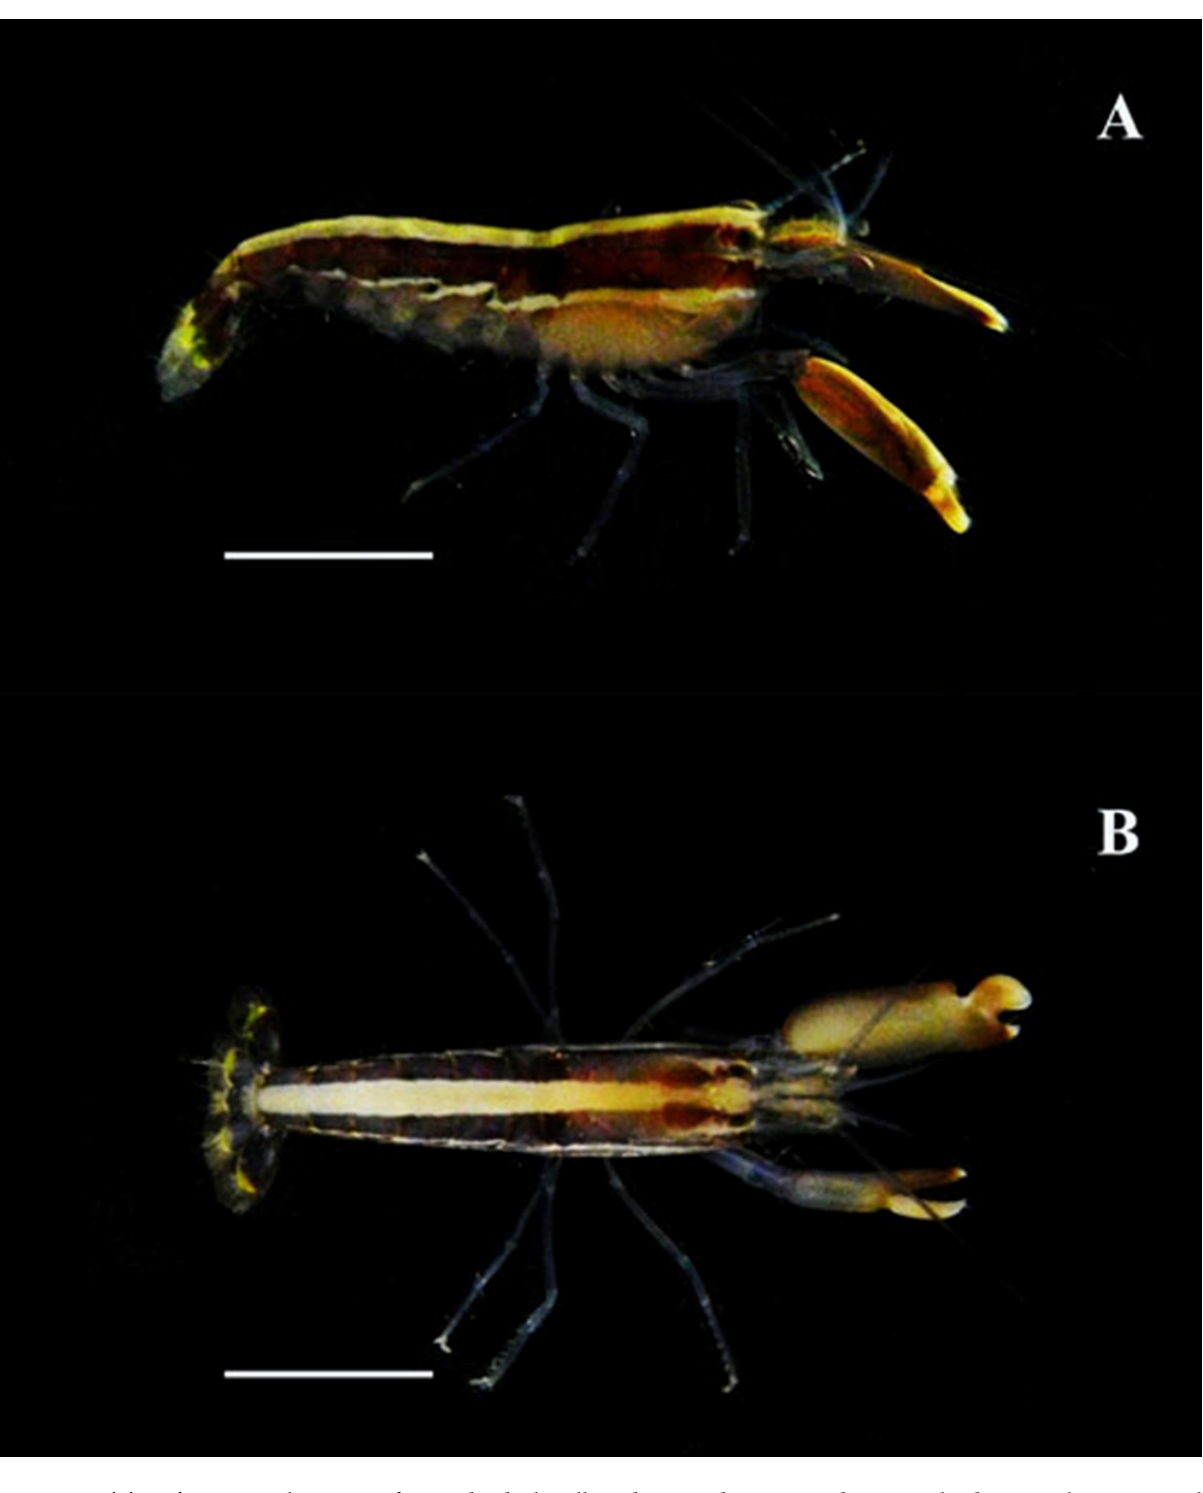
Figure 2. Alpheus formosus : color pattern from individuals collected at Laje de Santos and Vitoria Island, São Paulo State, Brazil (2015-2016). ( A ) Lateral view; ( B ) dorsal